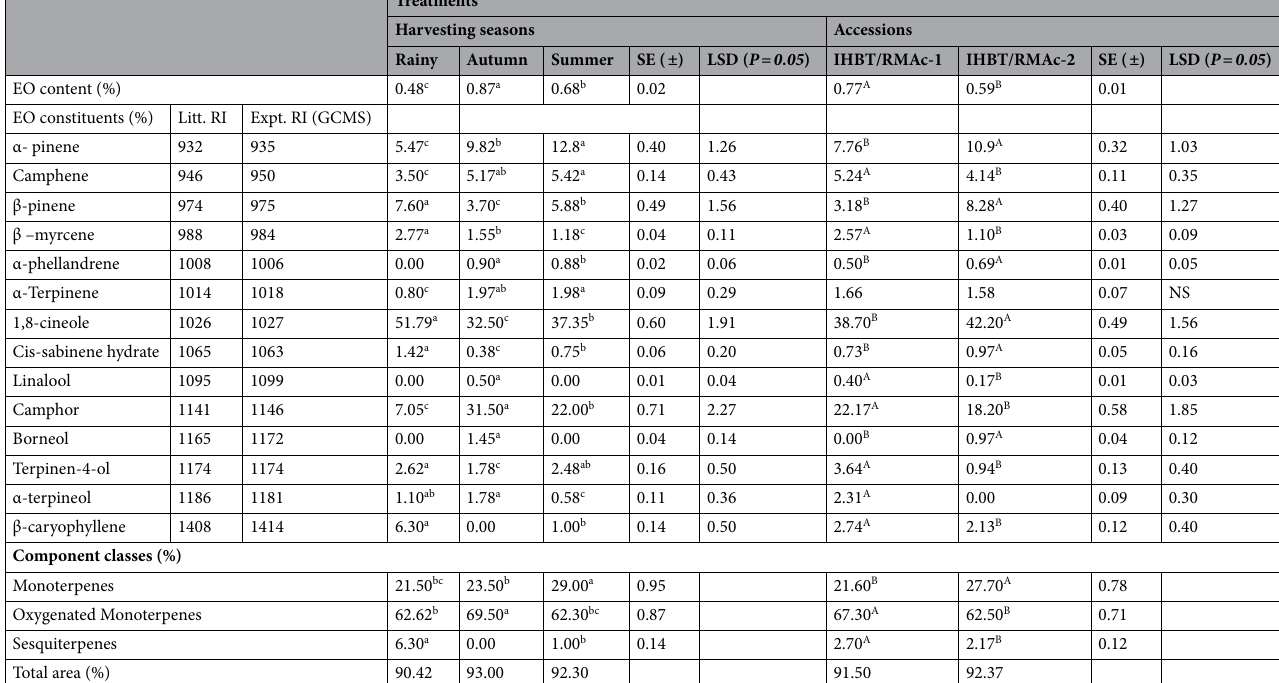
Table 2. Essential oil content, constituents and grouped chemical component classes of R. officinalis over different harvesting seasons and accessions. Means with the same letter in the same row did not differ significantly ( P =